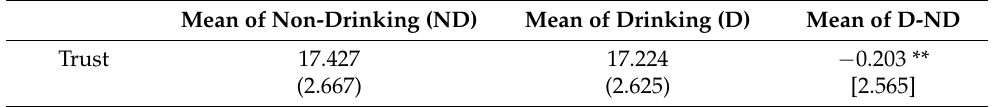
Table 3. Mean differences in Trust between drinking and